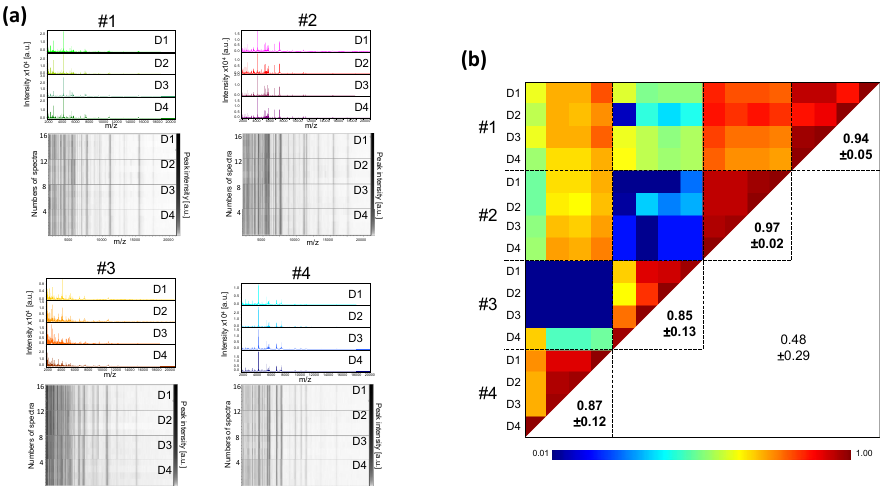
Figure 5. Inter-day reproducibility of saliva MS profiles from healthy individuals. ( a ) Representative saliva MS spectra and gel view of saliva MS spectra from four distinct healthy individuals (#1 to #4) collected with Salivette devices during four successive days (Day, D1, D2, D3, and D4). Per collection day, one MS spectra and the four replicates loaded on the MS plate for each individual are presented on the graphic and gel view, respectively. The gray scale in the right part of the panel correspond to the MS peak intensity level in arbitrary units (a.u.). ( b ) Composite correlation index (CCI) matrix representing the levels of MS spectra reproducibility between saliva samples. Bold numbers correspond to CCI values obtained for each individual in successive days. CCI are expressed as the mean ± standard deviation. #1 to #4: healthcare workers.